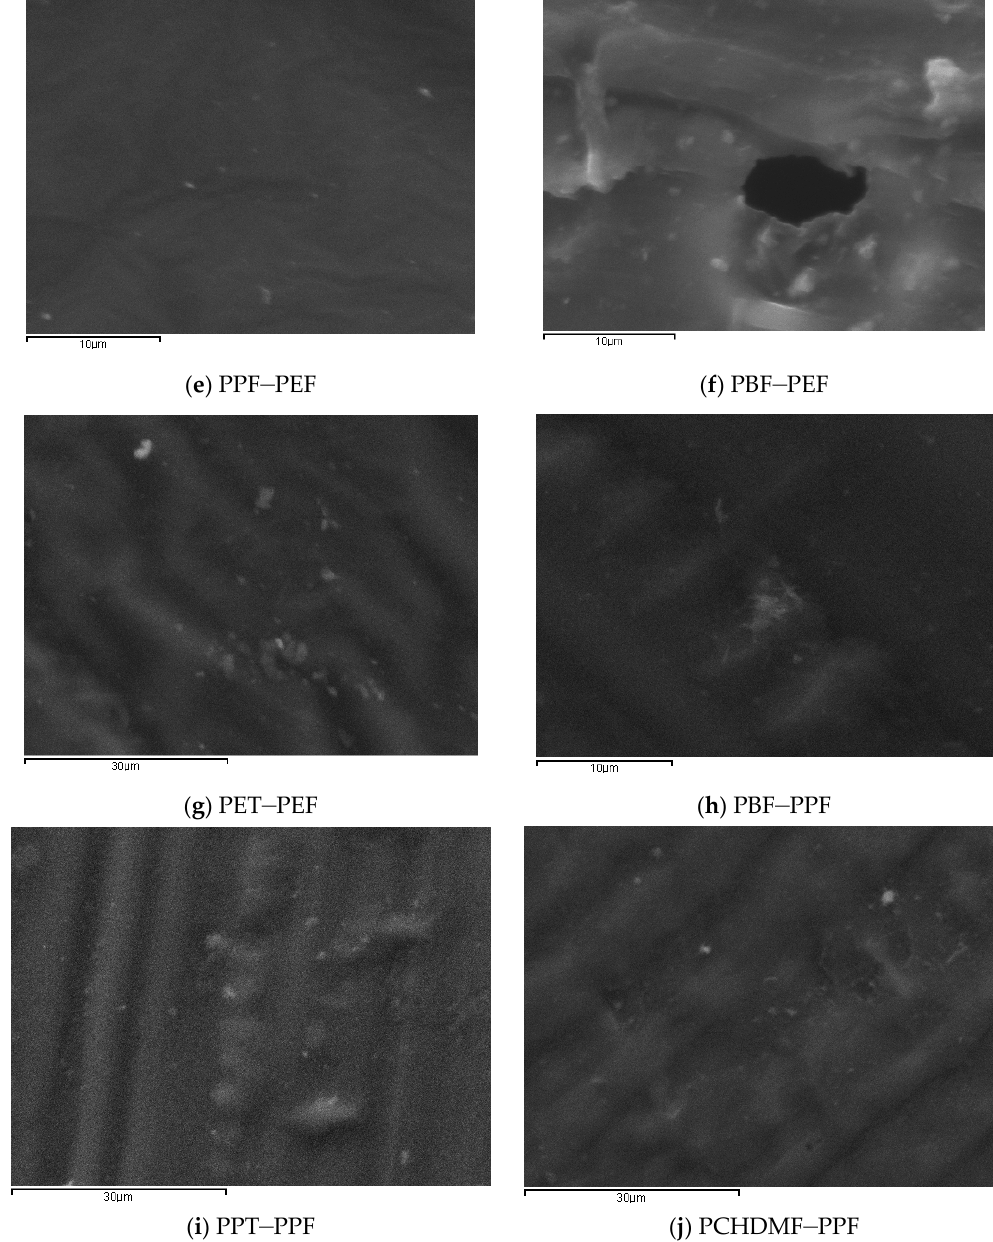
Figure 7. SEM photographs showing the melt-quenched samples of 50-50 blends: ( a ) PC–PEF, ( b ) PEN–PEF, ( c ) PET–PEF, ( d ) PCHDMF–PEF, ( e ) PLA–PEF, ( f) PPF–PEF, ( g ) PBF–PEF, ( h ) PBF–PPF, ( i ) PPT–PPF, ( j ) PCHDMF–PPF.